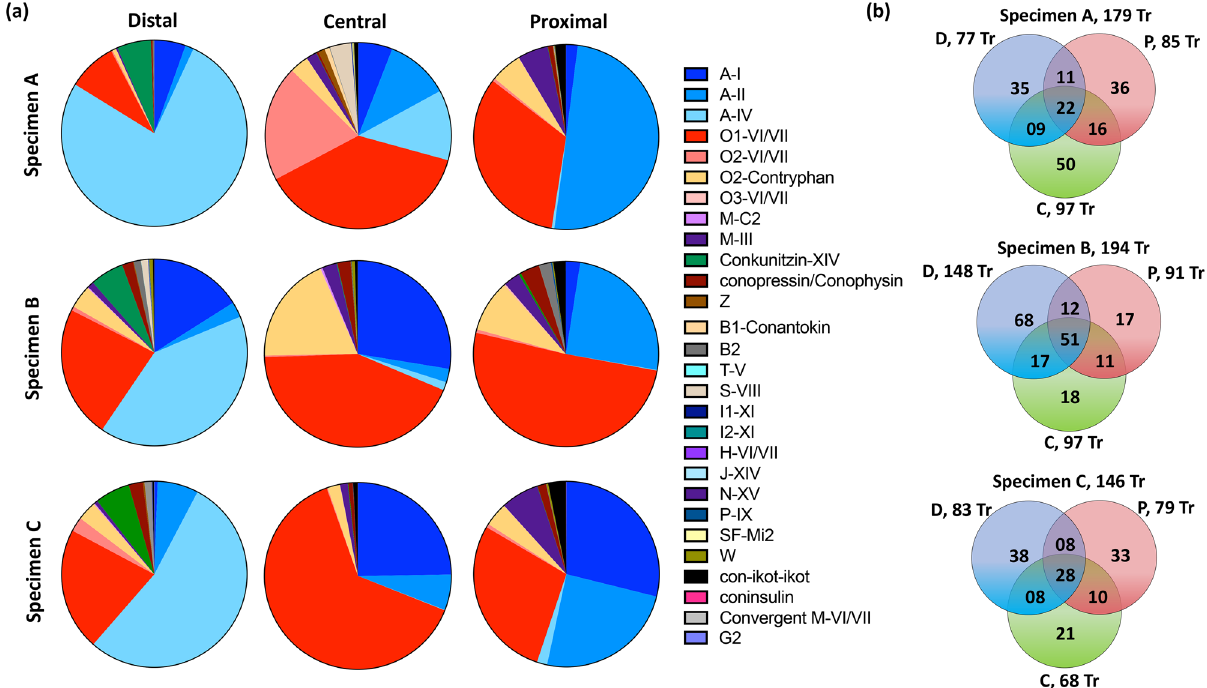
Figure 2. Comparison of the transcriptomic profiles of three venom duct sections (distal, central and proximal) obtained from three adult C. striatus (specimens A–C). (a) Venn diagram showing the common and unique conotoxin precursor transcripts among the three venom duct sections in three specimens of C. striatus. (b) Expression profiles (Relative TPM) of all identified superfamilies across the venom duct sections in three specimens of C. striatus . Tr transcript, D distal—blue, C central—green, P